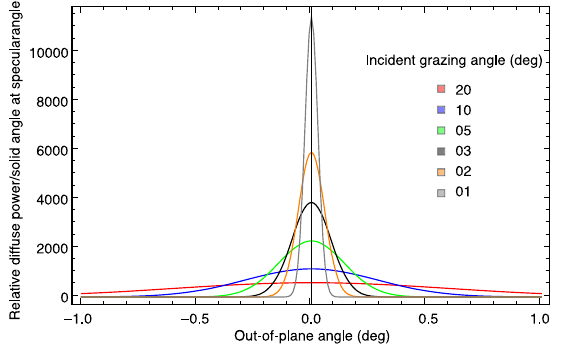
FIG. 7. Photograph of one of the aluminum vacuum chamber samples (Sample #1). The beam direction is parallel to the 7.5 cm long edge.